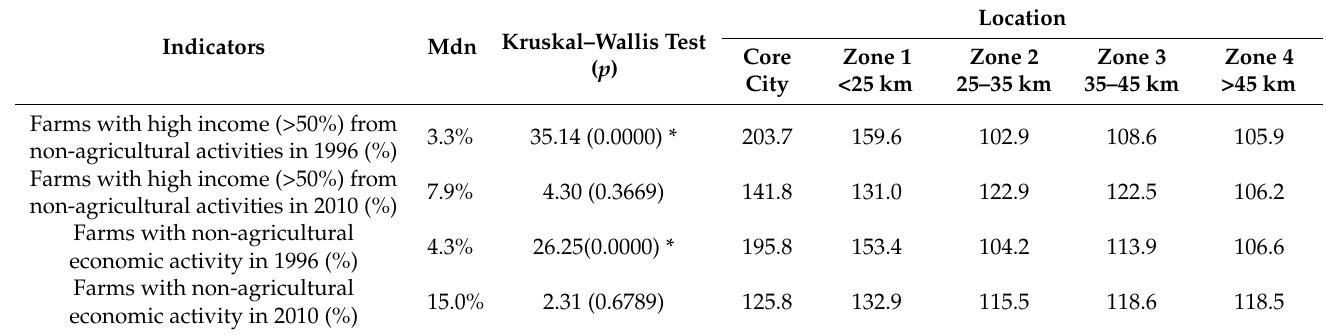
Table 9. Median and medium rank size of selected variables building factor F5, depending on the location.